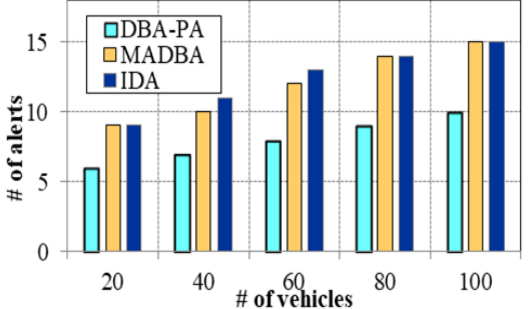
Figure 6. Number of Vehicles vs. Number of